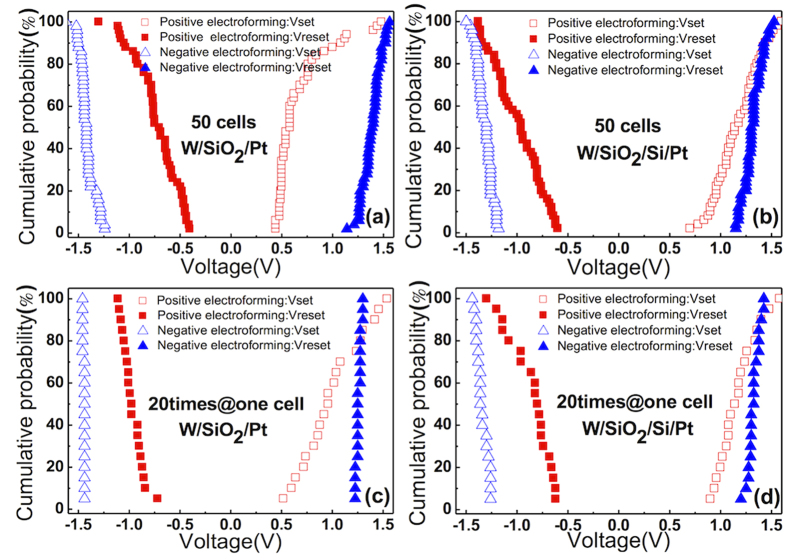
The cumulative probability graphs of Vset and Vreset with 50 cells and the repeating 20 times in one cell for the negative electroforming and the positive electroforming case, respectively, corresponding to (a,c) W/SiO2/Pt and (b,d) W/SiO2/Si/Pt.